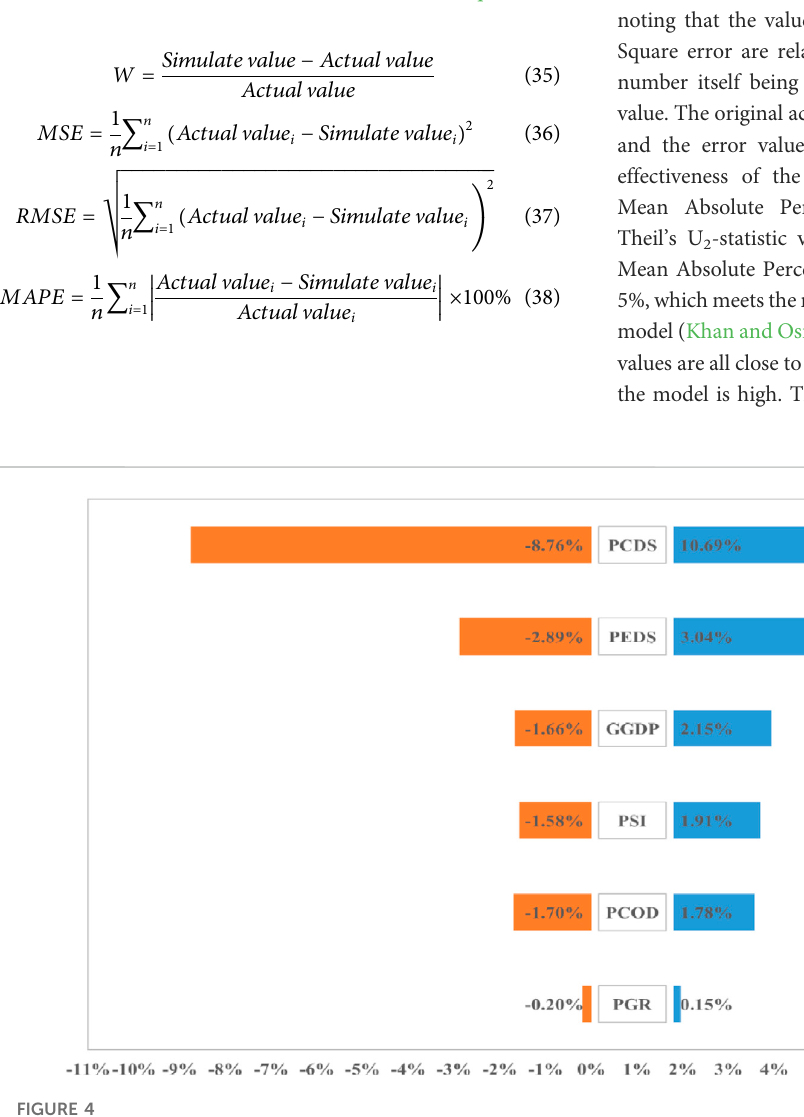
FIGURE 4 System model parameter sensitivity test